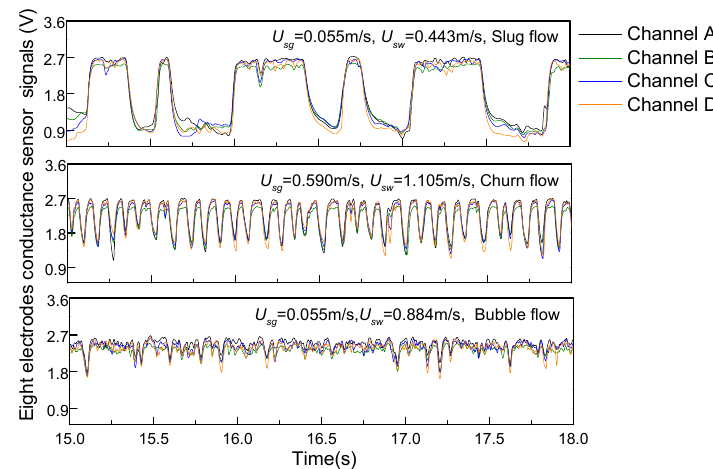
Figure 5. Output signals of the REFCS in gas–water two-phase flows.